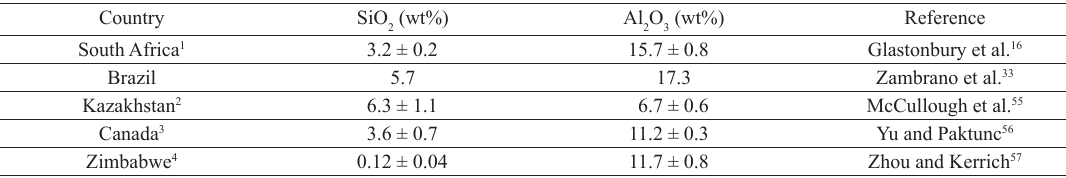
and Al O content of chromite from various countries. 2 2 3